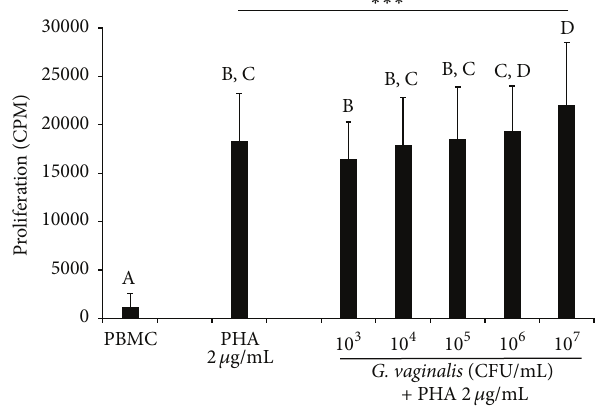
Figure 6: Modulation of PHA-induced lymphocyte proliferation after exposure to a range of G. vaginalis concentrations.As expected, 2 𝜇 g/mL PHA induced a strong proliferation of the lymphocyte control cells, reaching on average about 20000 cpm. Compared to the PHA-stimulated control cells, a significant slight increase in lymphocyte proliferation was observed with the G. vaginalis -treated cells at a high dose. Data are means (+ SD) of measures from 13 independent experiments. PBMC: PBMCs cultured for 72 h without any effector; PHA control: PBMCs only exposed to PHA (2 𝜇 g/mL) for 72 h; G. vaginalis : PBMCs exposed for 72 h to PHA (2 𝜇 g/mL) in the presence of 10 3 to 10 7 CFU/mL of G. vaginalis . Two-way ANOVA with post hoc Bonferroni test ( ∗∗∗ 𝑝 < 0.001 ). A, B, C, and D: means with different superscript letters are significantly different from each